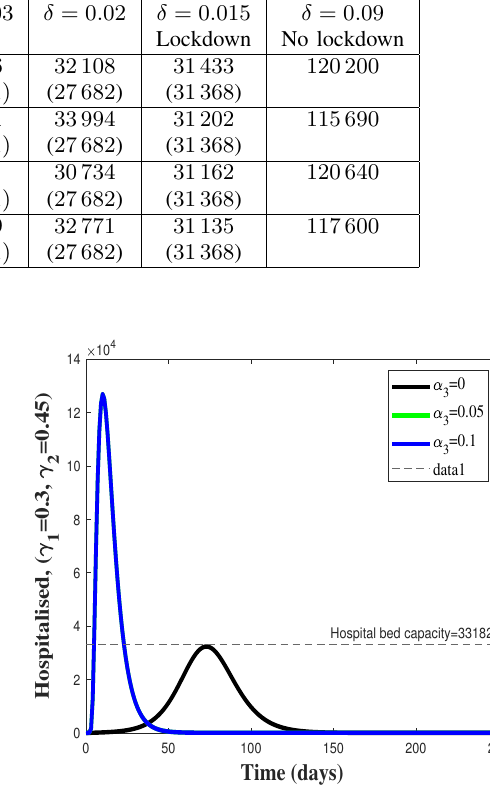
Fig. 9: Population level plots for hospitalized in- dividuals for varying values of γ 2